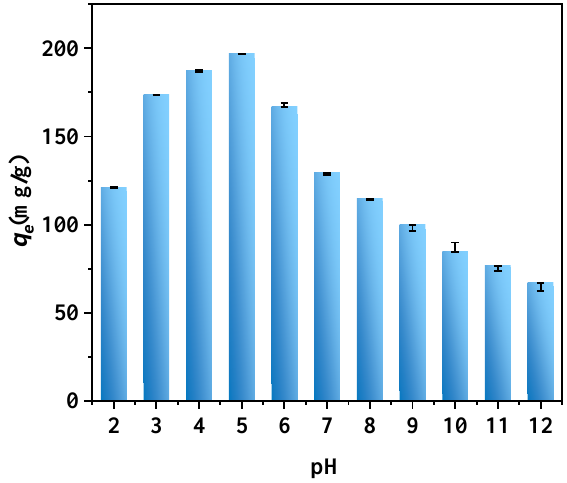
Figure 7. Effect of different pH levels on the phosphorus adsorption capacity.